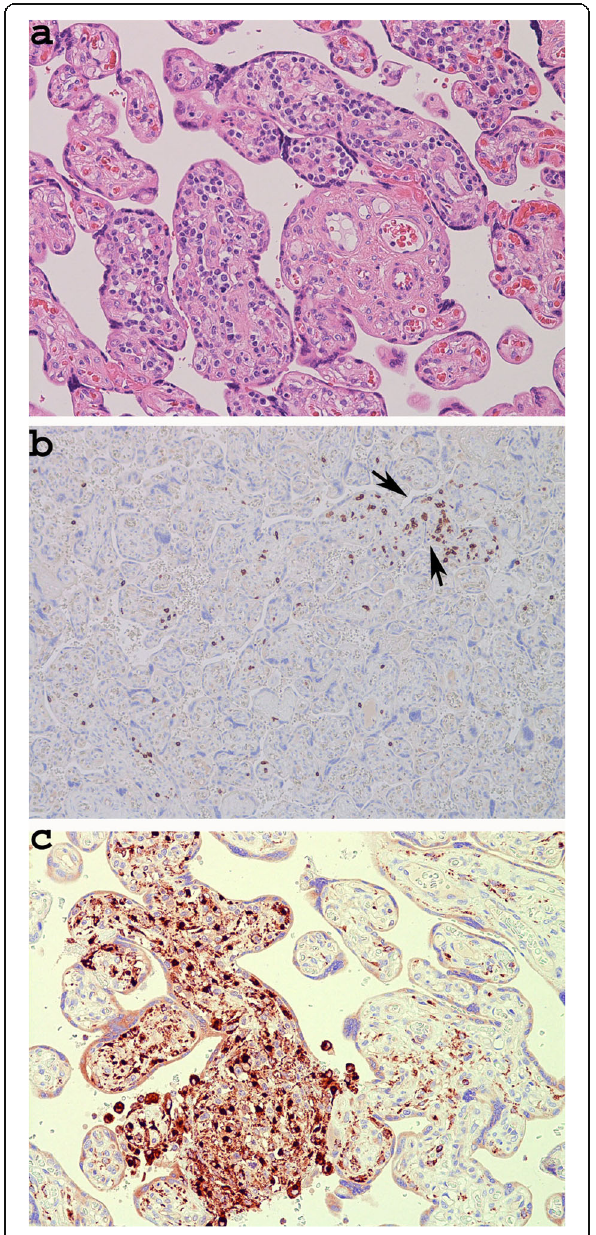
Fig. 5 CD15 immunoreactivity in placental tissue. Negativity for CD15 in case 1, both in vessels of stem villi and capillaries of terminal villi (Case 1, a × 100, Arrows: arteries, Arrowhead: venous vessel); Focal positivity in a venous vessel of stem villi and in the a few capillaries of terminal villi (Case 3: b × 100; Arrow: Venous vessel, Arrowheads: positive capillaries); negativity for CD15 in vessels of stem villi and positivity in many capillaries, of a focus of terminal villi (Case 4: c × 100; Arrows: arteries, Arrowhead: venous